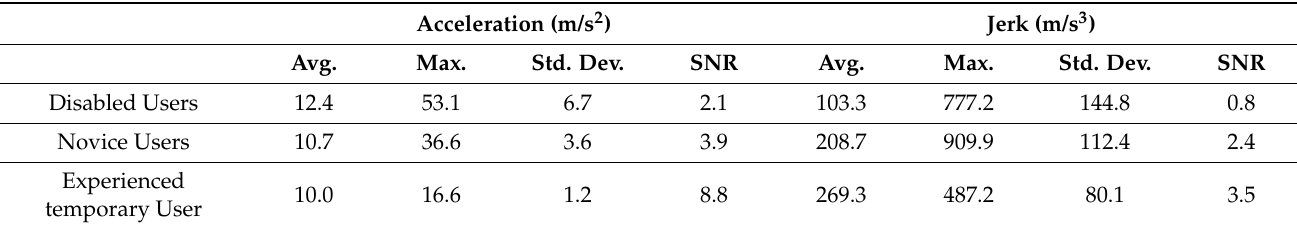
Table 2. Analysis of motion measurement (average of all values (Avg.), maximum of all values (Max.), Standard Deviation of all values (Std. Dev), SNR of all values).